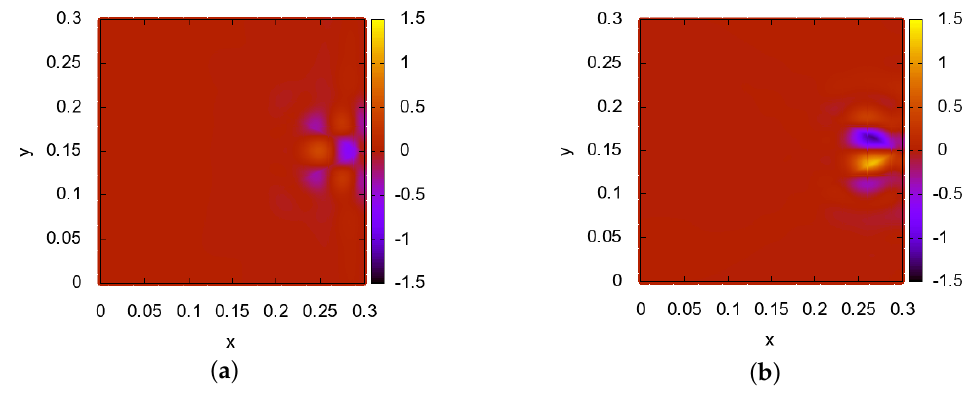
Figure 10. Test 3. Inverse problem 2. Numerical solution. 900 iterations. ( a )—computed solution q 1 ( x , y ) . ( b )—computed solution q 2 ( x , y )